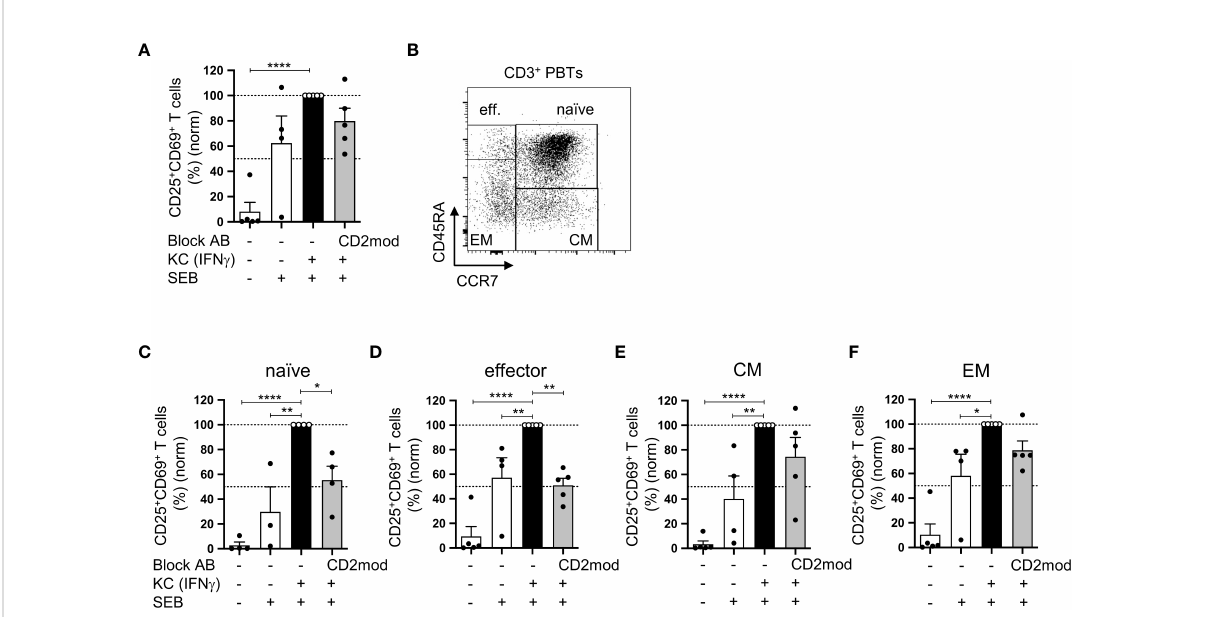
FIGURE 1 CD58/CD2-dependent costimulation is necessary for KC-mediated activation of naïve and effector T cells but not of memory T cells. CD3 + PBTs, either with or without CD2 downmodulation (CD2mod), were cocultured for 24 h with untreated KCs or IFN g -pretreated KCs loaded with (+) or without (-) SEB. Surface receptor expression was assessed by fl ow cytometry. (A) Statistical evaluation of CD25 and CD69 surface expression after 24 h of coculture (n = 5 individual T cell donors). (B) Representative dot plot of CD45RA and CCR7 surface expression on CD3 + PBTs. C-F: Statistical evaluation of CD25 and CD69 expression on T cell subpopulations after 24 h coculture (n ≥ 4 individual T cell donors). CD3 + PBTs were categorized into (C) naïve (naïve, CD45RA + CCR7 + ), (D) effector (effector, CD45RA + CCR7 - ), (E) central memory (CM, CD45RA - CCR7 + ) and (F) effector memory (EM, CD45RA - CCR7 - ) PBTs. Data was normalized to PBTs cultured with IFN g -pretreated KCs loaded with SEB (black bar). Data is represented as mean ± SEM. ****=p<0.0001; **=p<0.01;